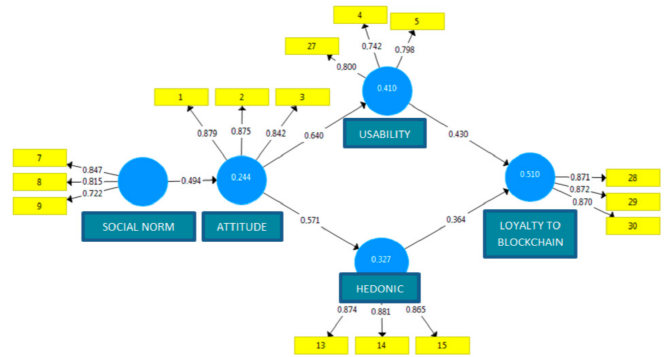
Figure 2. Measure model basic data. Source: Own